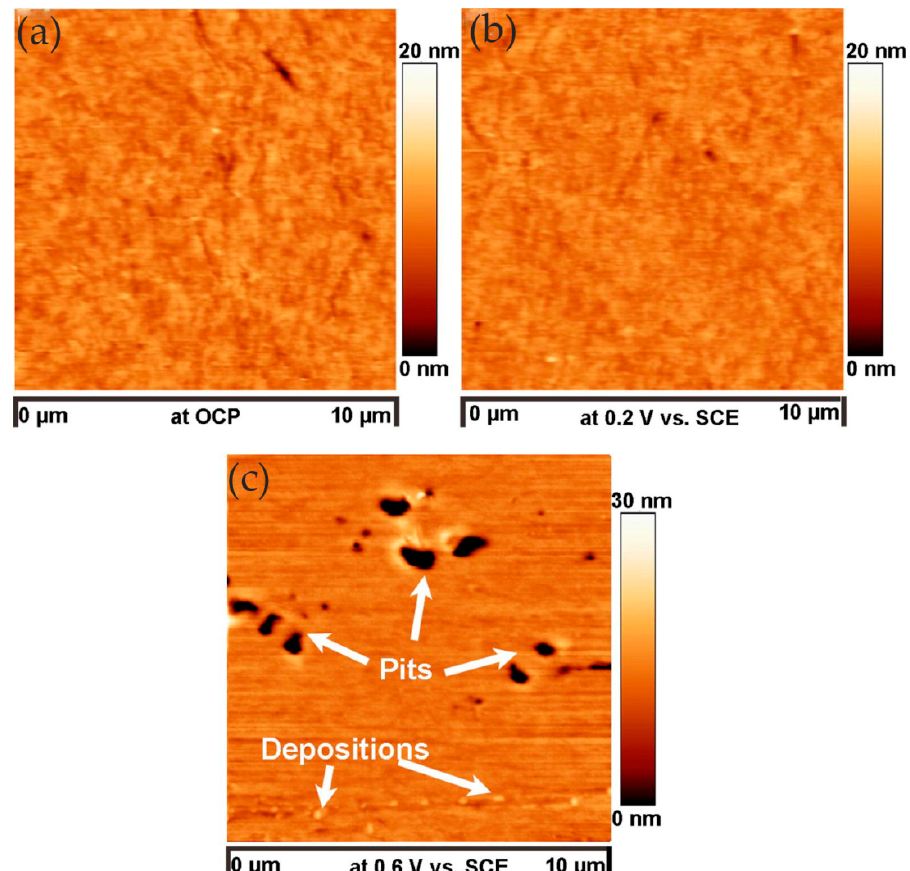
Figure 25. In situ EC-AFM topography images of the Al 0.3 CoCrFeNi high-entropy alloy (HEA) in a 3.5 wt% NaCl solution after 10 min of exposure at ( a ) OCP, ( b ) 0.2 V, and ( c ) 0.6 V. Reprinted with permission from Reference [63]; copyright 2018 Elsevier Ltd.